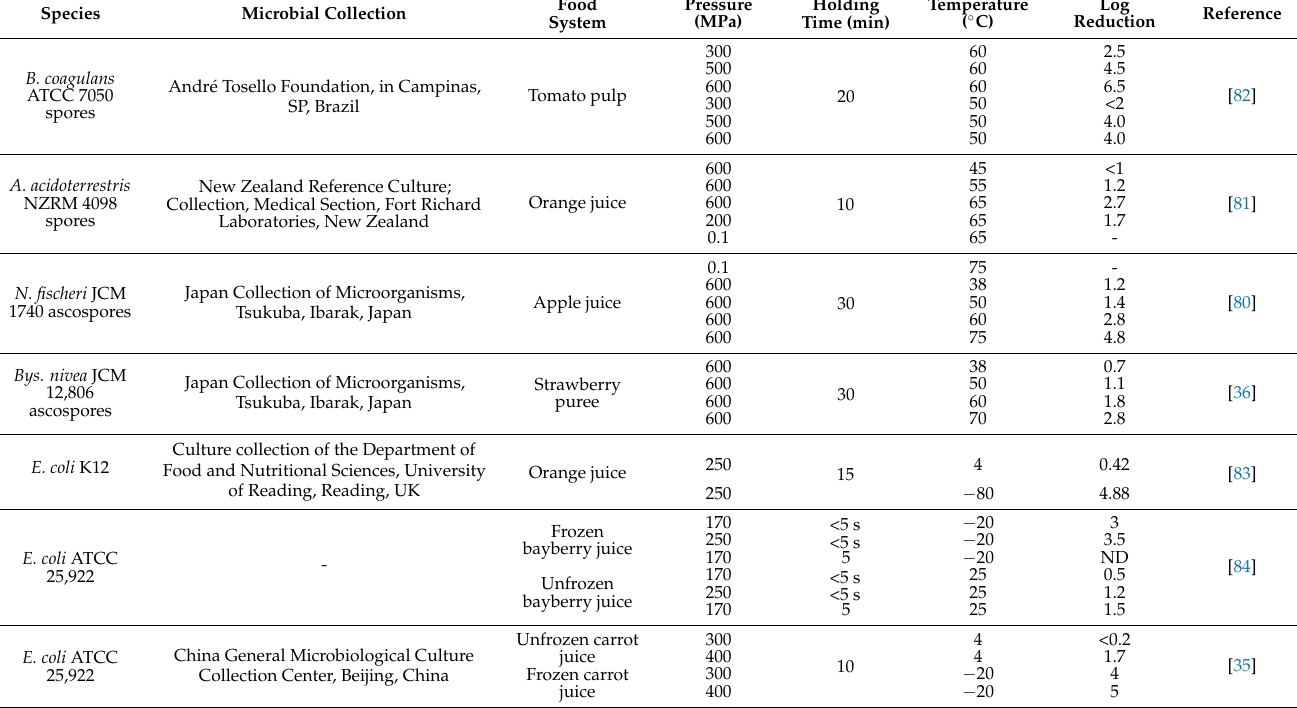
Table 3. Inactivation effect of HPP and HPTP on harmful microorganisms in different food